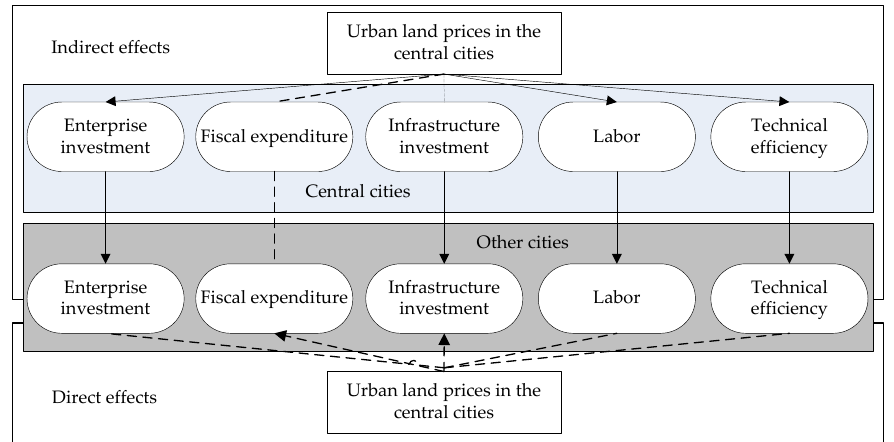
Figure 8. The impacts of urban land prices on the production factors in urban agglomerations.